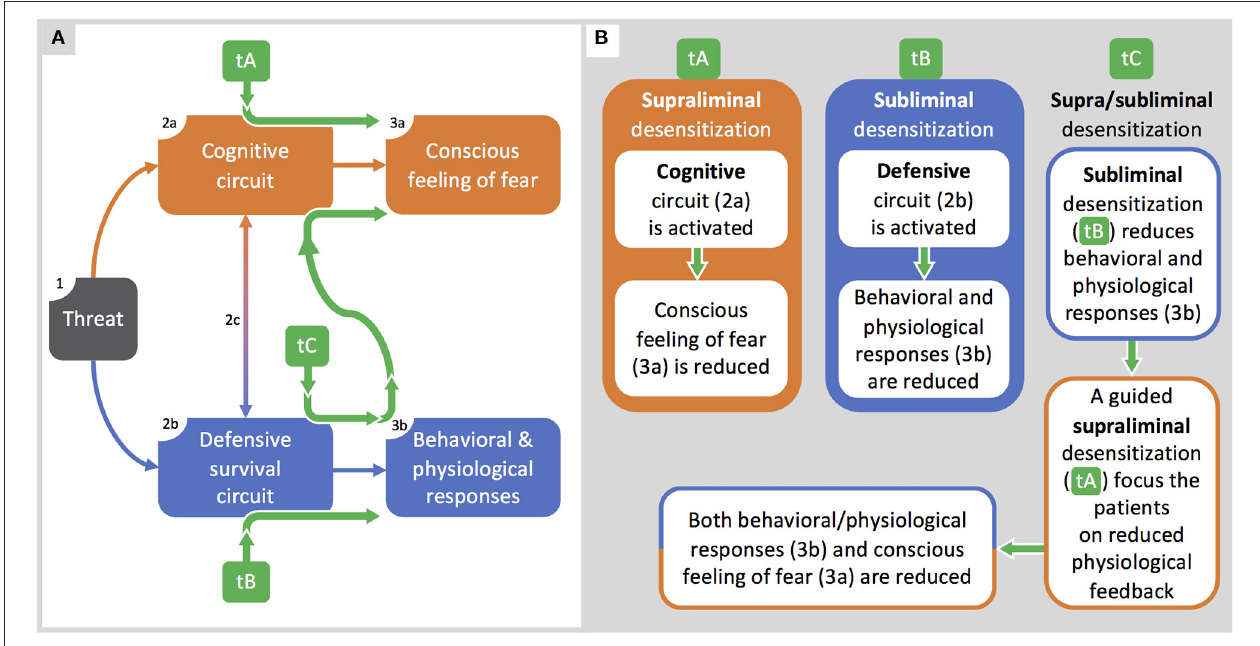
FIGURE 3 | Integrated supra/subliminal therapeutic model. (A) : the model by LeDoux and Pine (2016) is integrated with the therapeutic pathways (green arrows) described in (B) . (B) : along with the representation of therapeutic protocols based on supraliminal (tA) or subliminal (tB) desensitization, here we propose a model (tC) integrating both tA and tB organized to optimize therapeutic